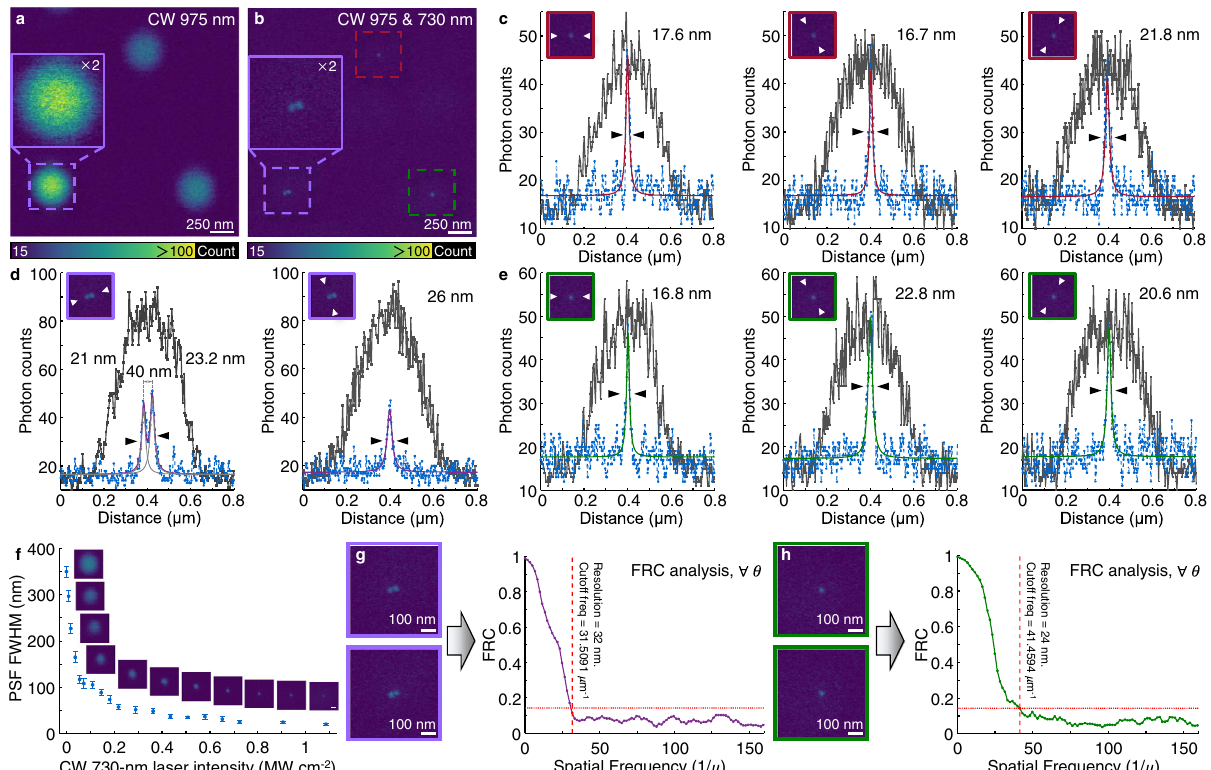
Fig. 4 | SMED microscopy for single-particle super-resolution imaging. a , b ,ImagingofNaGdF 4 :Yb/Tm(18/0.3%)nanoparticles(~11nmindiameter)witha laser scanning microscope irradiated with a CW 975-nm Gaussian beam ( I 975 =98 kWcm − 2 ) and a dual-beam system (975-nm Gaussian beam and CW 730-nm doughnut-shapedbeam, I 730 =1.09MWcm − 2 , P 730 =4.85mW),respectively. Images shown are averages of two repeated. Image dimensions: 800×800 pixels; pixel size: 3nm; pixel dwell time: 200 μ s; acquisition time: 130s. Image reproducibility can be seen in Supplementary Fig. 10. c – e Intensity pro fi les of the nanoparticles fromred,purple,andgreendottedboxesin a , b ,respectively.Theintensitypro fi les were measured radially and the insets show the corresponding measurement